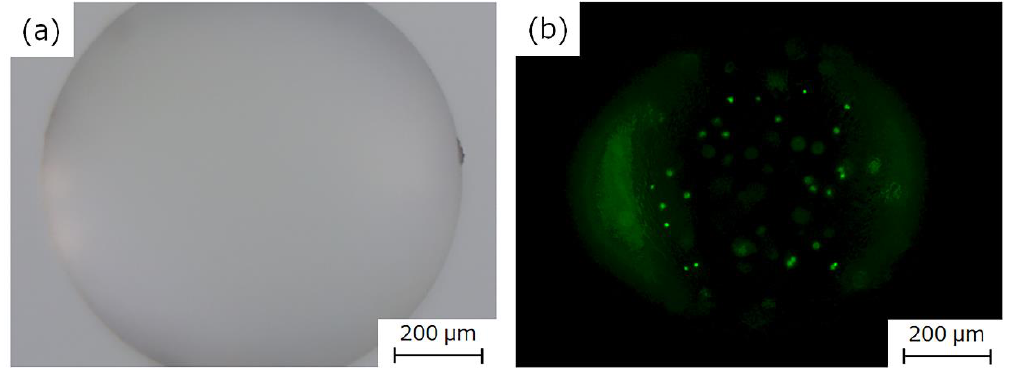
Figure 8. Photographs of Ca-Alg gel including fluorescent particles: ( a ) optical image and ( b ) fluorescent image.